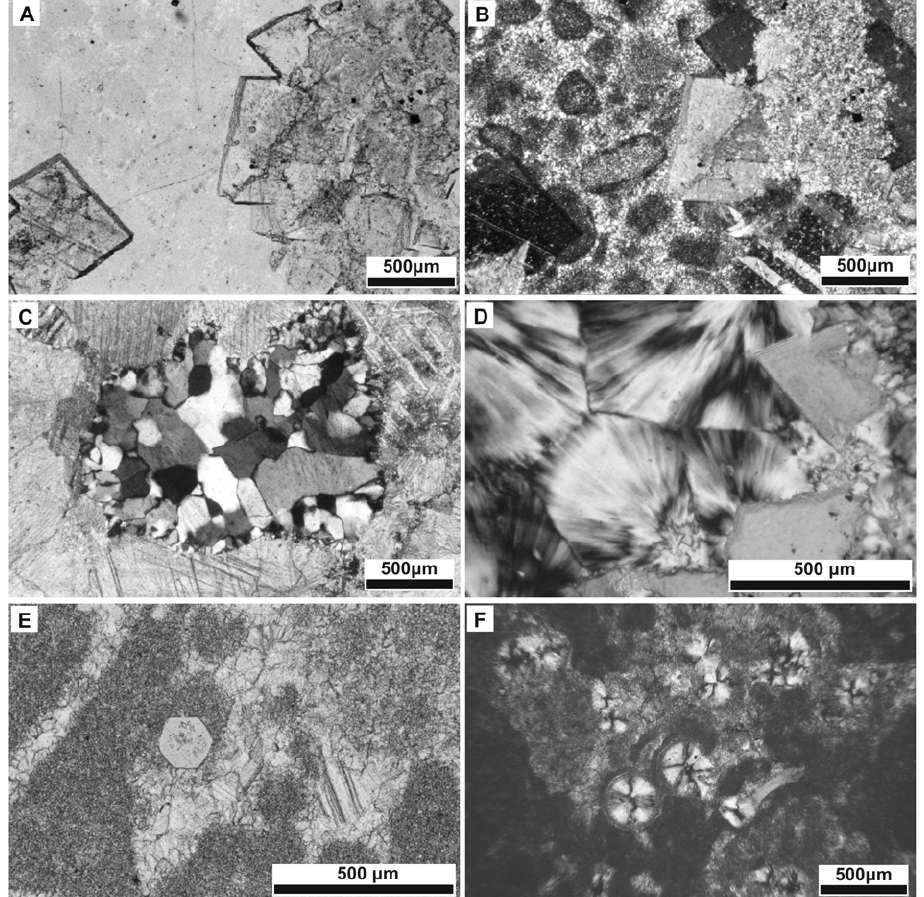
Fig. 4 – Different types of chert in thin section. A – Micro-quartz associated with well devel- oped dolomitic rhombs. Plane-polarized light. B – Same section that A, crossed nicols. It is possible to see the carbonate grains (peloids) completely replaced by micro-quartz. C – Cavity occupied by mega-quartz, drusy texture. Crossed nicols. D – Fibrous chalcedony associated with dolomite. Crossed nicols. E – Autighenic hexagonal quartz. Crossed nicols. F – Silica microspheres. Crossed